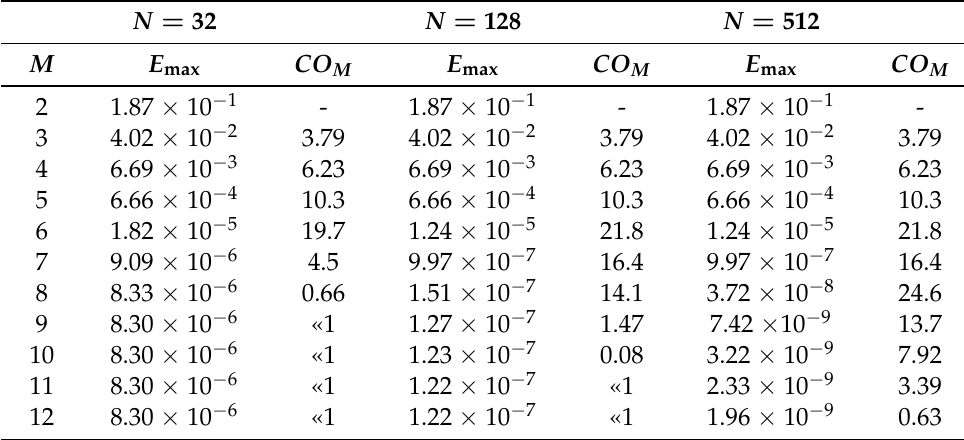
Table 3. The MAE and CO M versus the M with the fixed number of harmonics N . N = 32 N =